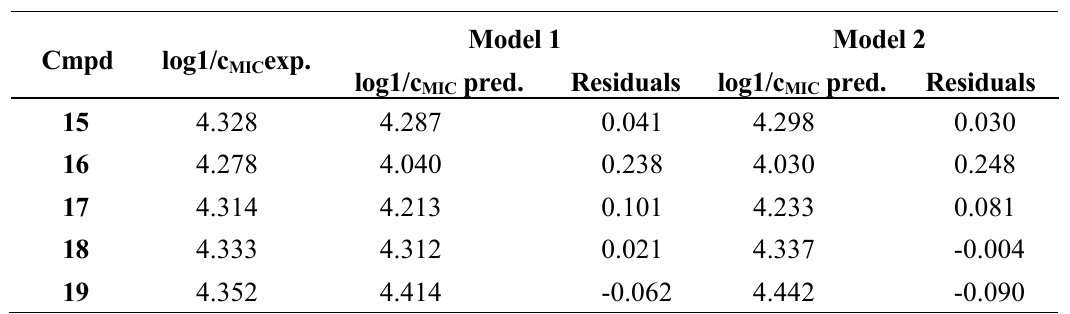
values of benzimidazoles tested against 6. Predicted log1/c MIC Pseudomonas